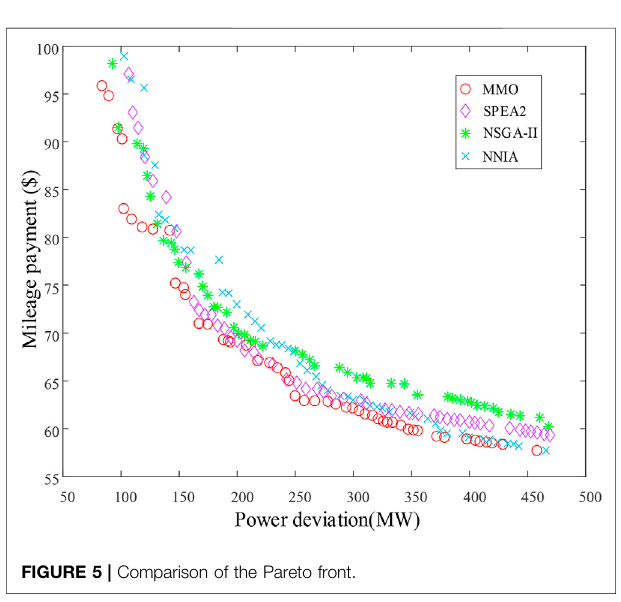
FIGURE 5 | Comparison of the Pareto front.